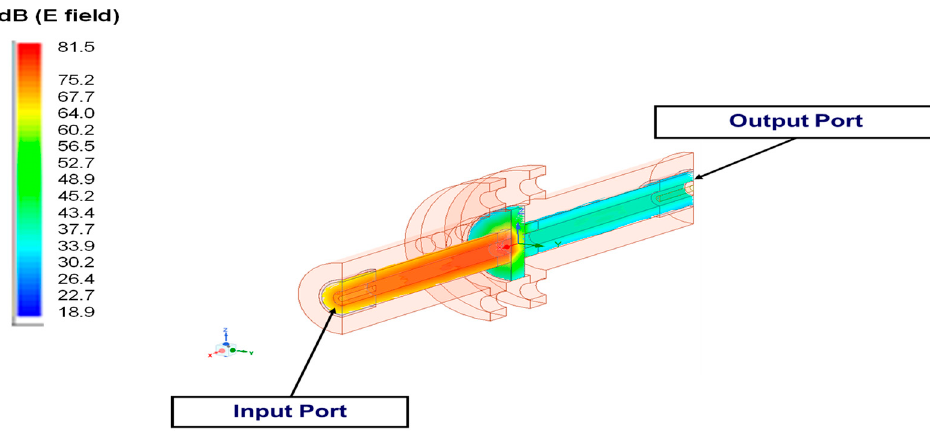
Figure 7. Simulation of the E-Field at 1.05 GHz for the PPS sample in the EMI fi xture.